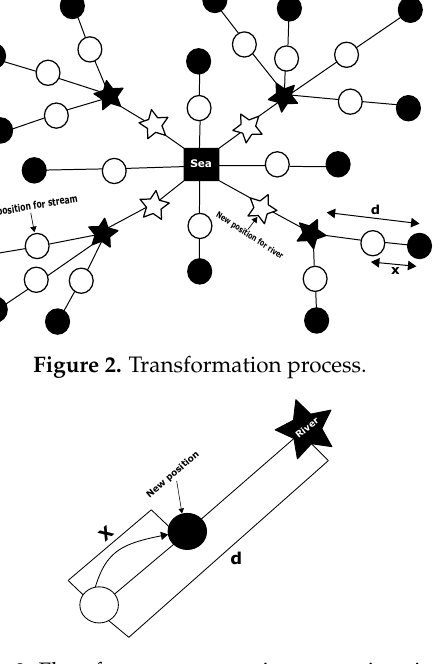
Figure 3. Flow from a stream to its connecting river.